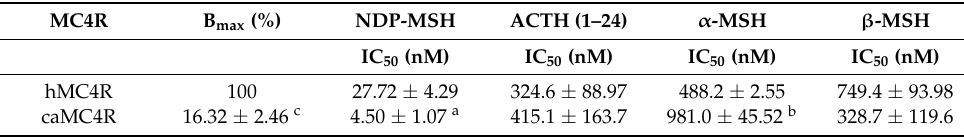
Table 1. The binding properties of